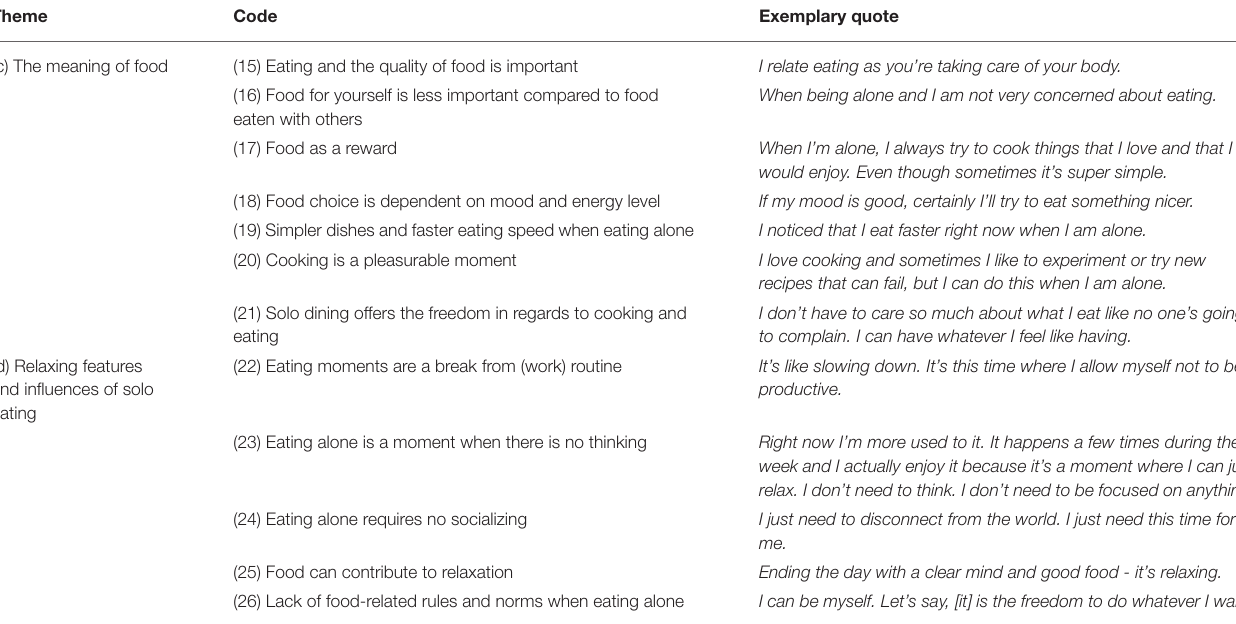
TABLE 5 | Overview of themes, codes, and exemplary quotes. Theme Code Exemplary